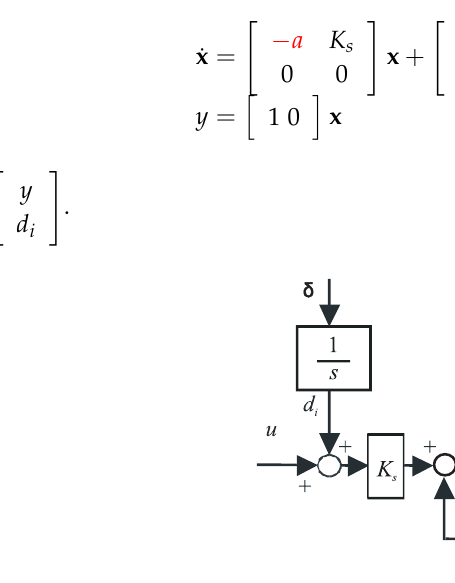
Figure 2. Input disturbance d i may be interpreted as a new plant state of an integrator with a non-controlled and non-measurable input δ